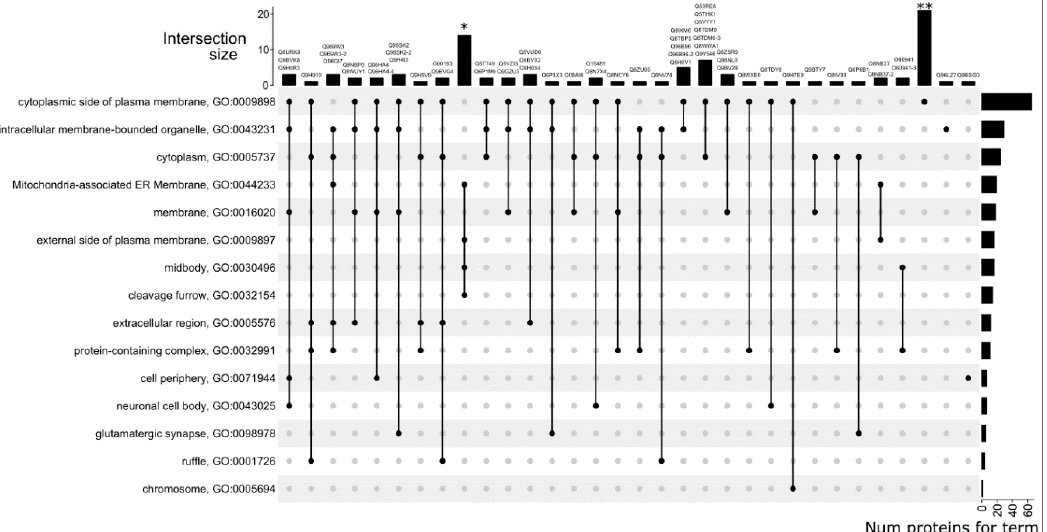
Figure 4. Cellular components predicted for 93 uPE1 proteins. * denotes the following set of proteins: A2RUT3, A6PVS8, Q2NL68, Q4KMZ1, Q6IPT2, Q6IPT2-2, Q7Z5L2, Q8N3J3, Q8N3J3-3,